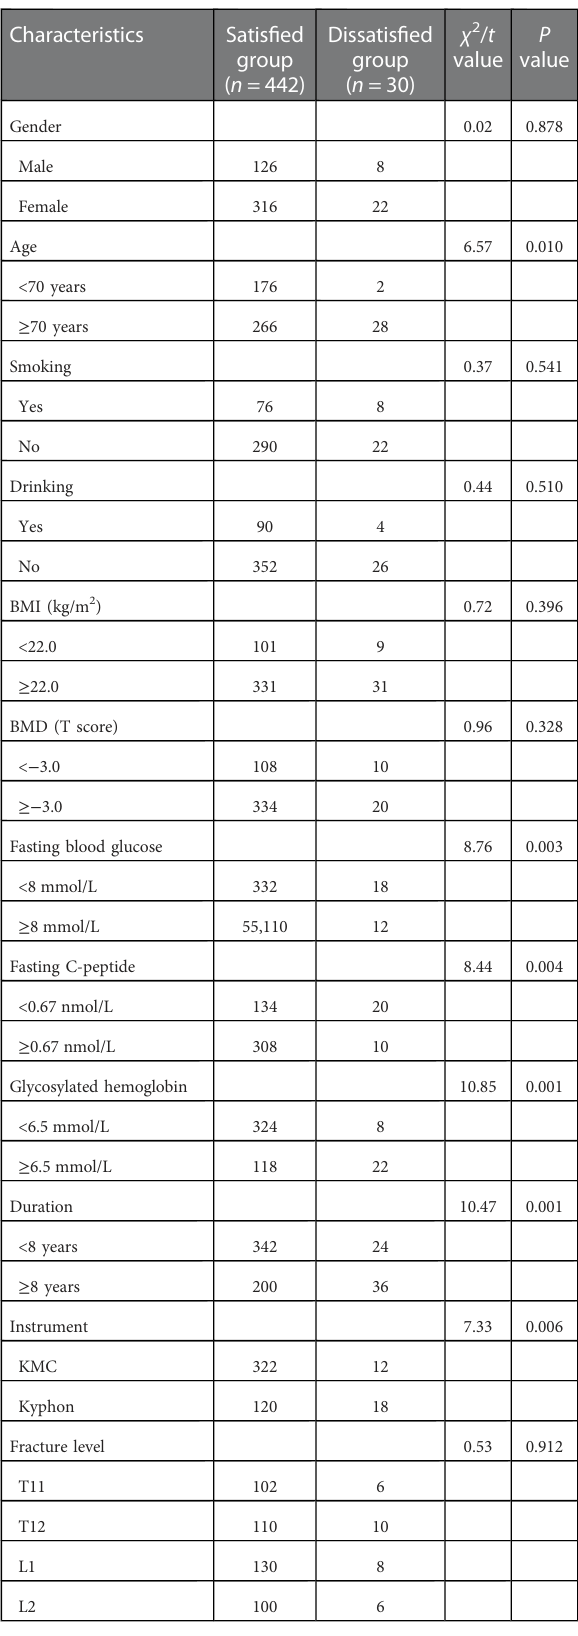
TABLE 3 Univariate analysis of patient satisfaction.